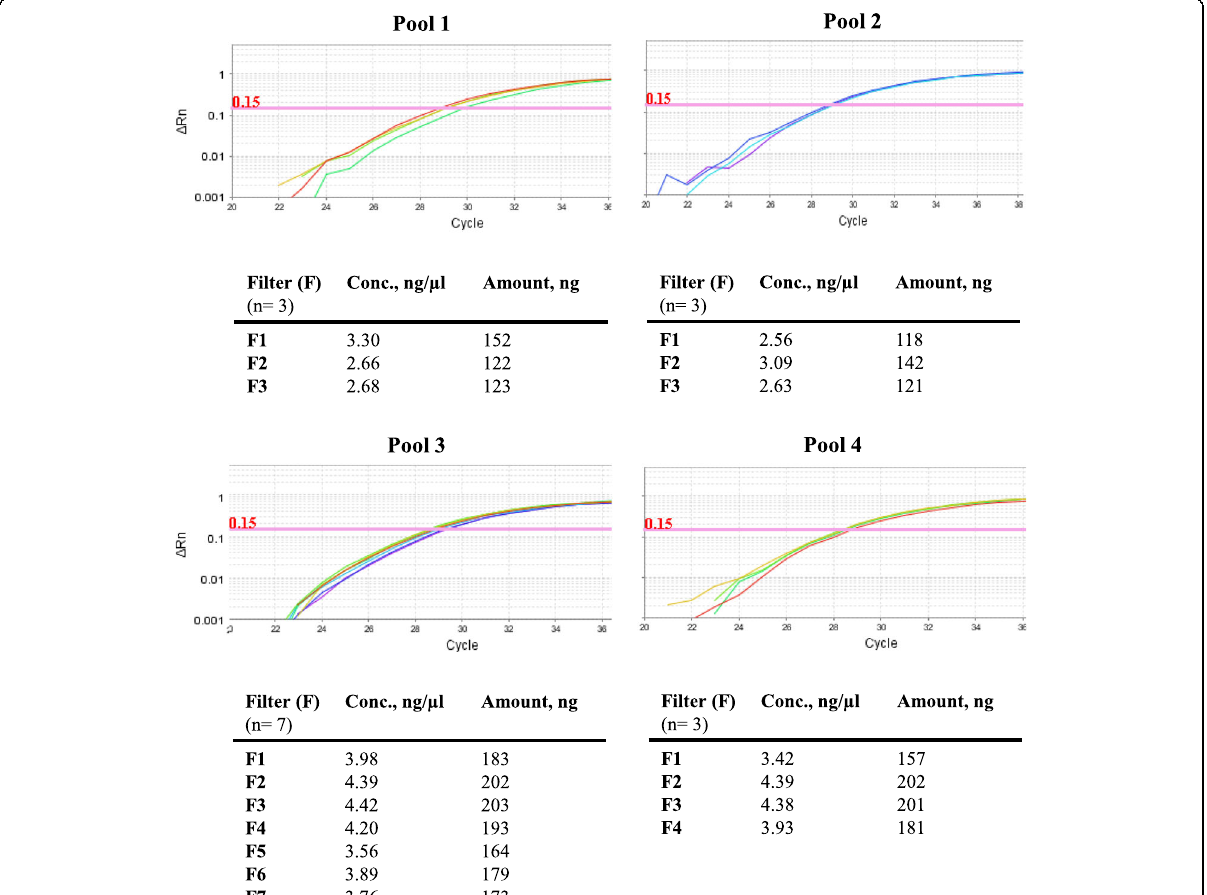
Fig. 2 DNA integrity assessed by PCR amplification of GLOBIN gene. DNA concentrations were determined by fluorometry. The GLOBIN gene was amplified with an amount of urine DNA comprised between 10 and 18 ng (4 μ l of DNA sample) from each Filter (F). Amplification curves are shown from Pool 1 to Pool 4, respectively